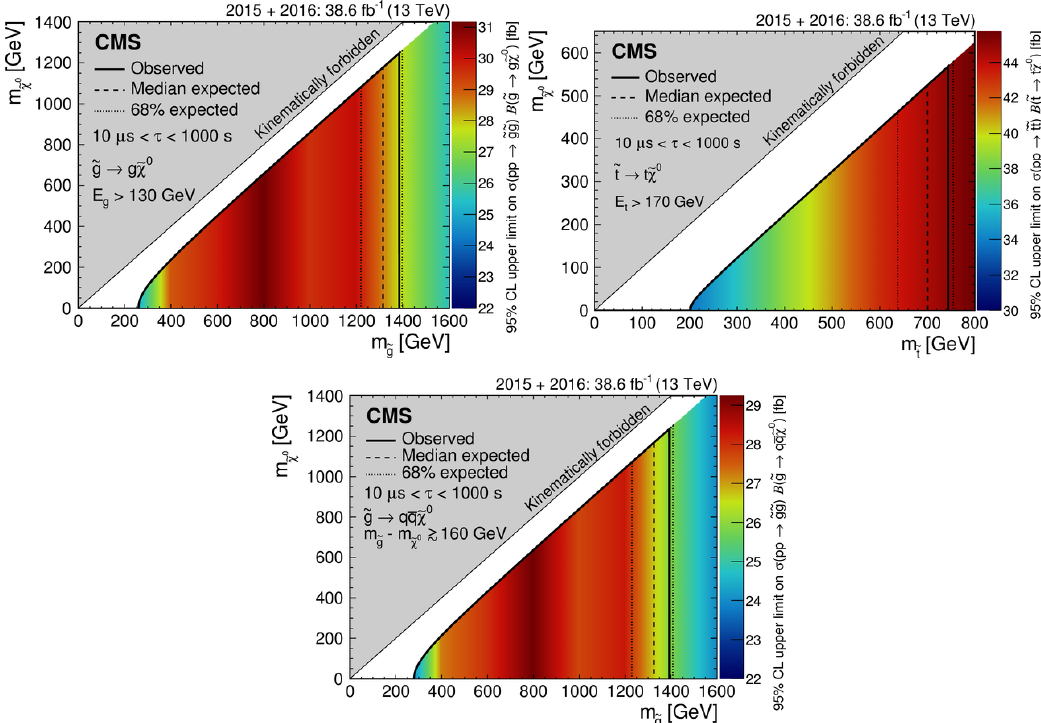
Figure 6 . The 95% CL upper limits in the neutralino mass vs. gluino (top squark) mass plane, for lifetimes between 10 (cid:22) s and 1000 s, for combined 2015 and 2016 data for the calorimeter search. The color map indicates the 95% CL upper limits on B (cid:27) . The mostly triangular region de(cid:12)ned by the black solid (dashed) line shows the excluded observed (expected) region. We show gluinos that undergo a two-body decay (upper left), top squarks that undergo a two-body decay (upper right), and gluinos that undergo a three-body decay (lower).